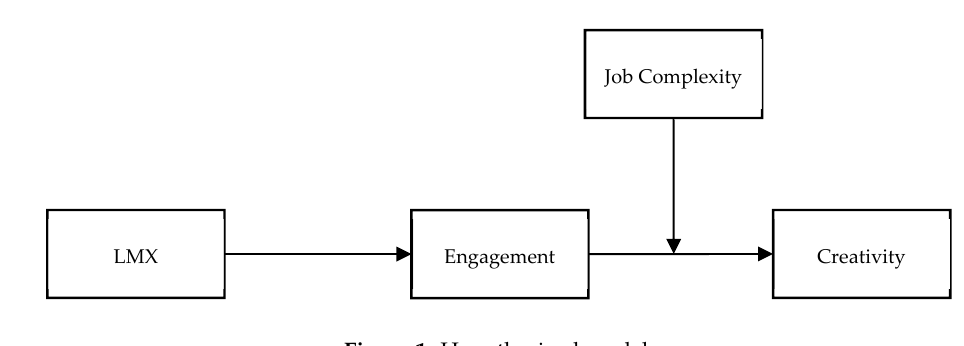
Figure 1. Hypothesized Figure 1 . Hypothesized model.